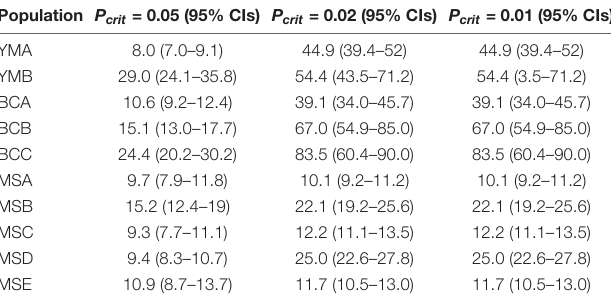
TABLE 5 | The effective population size with three levels of the lowest allele frequency ( P crit ) for the 10 populations of P. emblica .